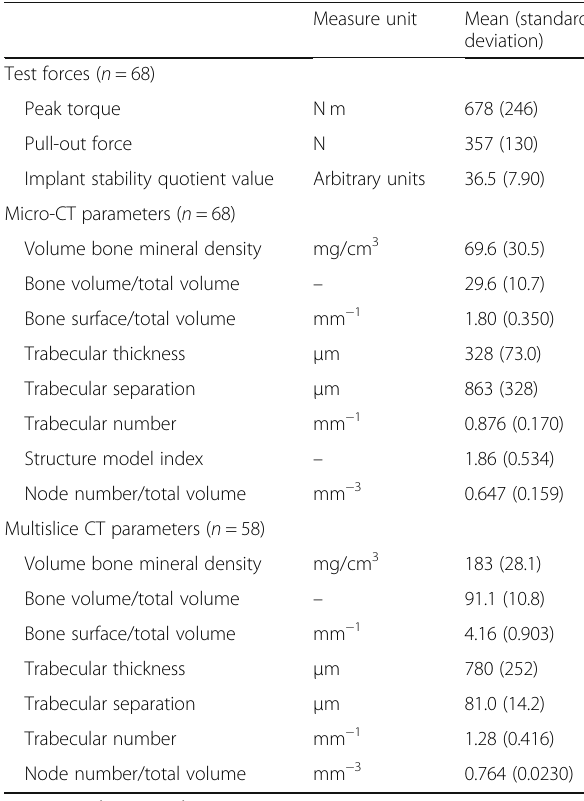
Table 1 Summary of the three test forces and parameters of the vertebrae on micro-CT and MSCT